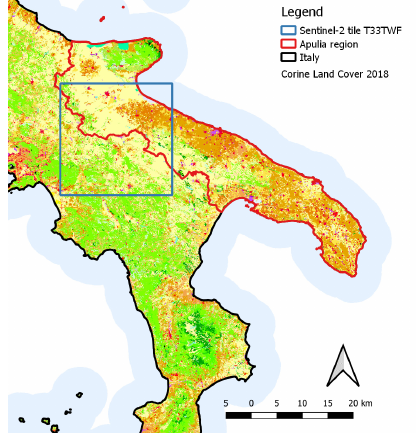
Figure 4. Sentinel 2 tile T33TWF location and